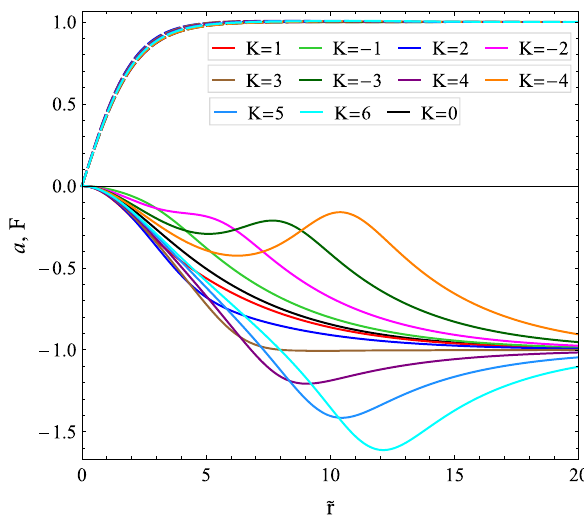
Fig. 14 Ansatz functions a (solid curves) and F (dashed curves) of the vortex-Q-ball system for the first few azimuthally excited states. The parameters of the vortex-Q-ball system are the same as in Fig.